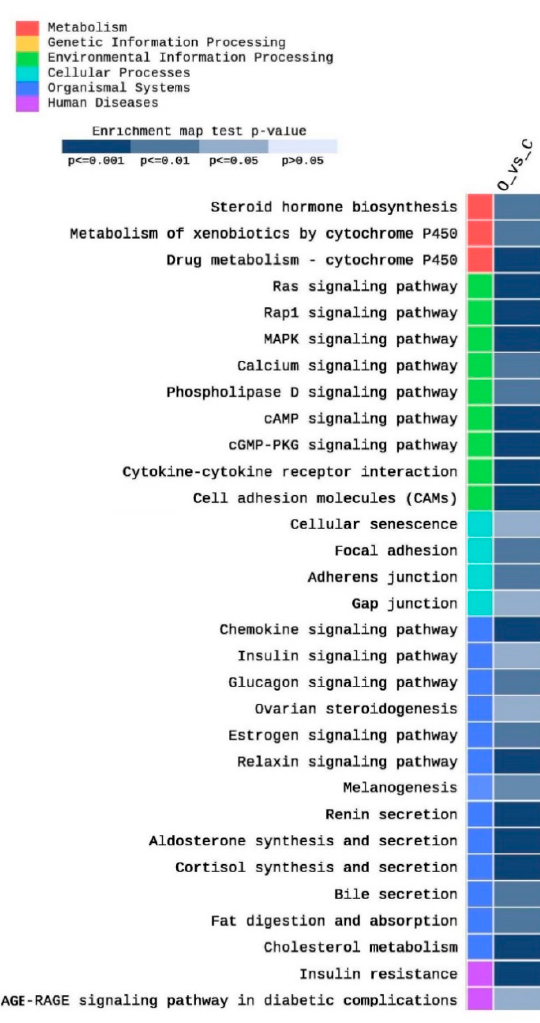
Figure 5. Heat map of the enriched pathways of the KEGG database after filtration of the significantly expressed genes (|FC| > 2) and adjusted p < 0.05.